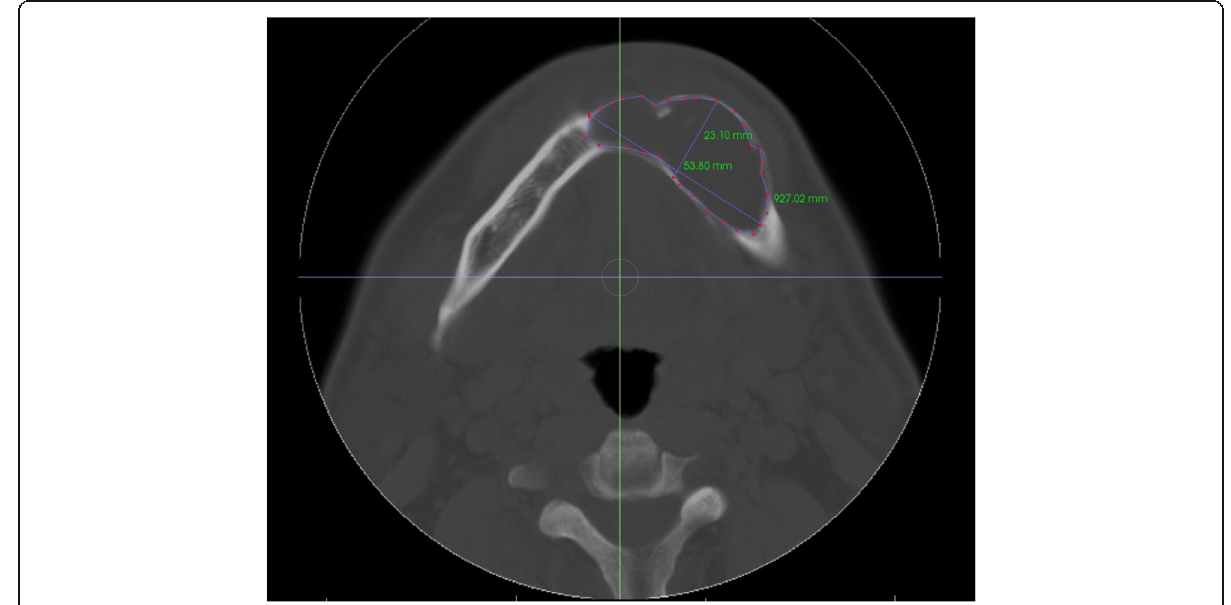
Fig. 2 The size of an area in axial cut and BL, MD width of lesion is measured